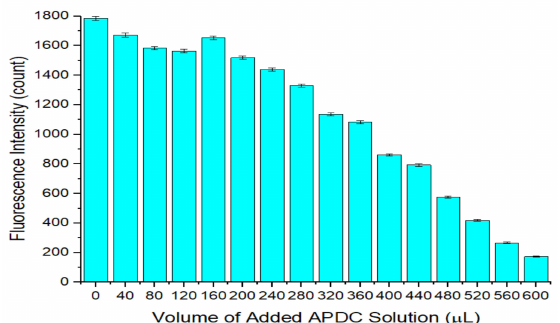
Figure 4. Relationship between the fluorescence intensity of the QD solution with added cadmium standard and the volume of the added APDC solution. Concentration of Tris-HCl bu ff er solution: 10 mmol / L. pH of Tris-HCl bu ff er solution: 8.5. Concentration of added QD solution: 5 µ mol / L. Concentration of added APDC solution: 100 µ mol / L. Concentration of cadmium standard solution: 1 g / L. Addition order: Tris-HCl bu ff er solution (2 mL) → QD solution (0.4 mL) → APDC solution (0–0.6 mL) → cadmium standard solution (0.001 mL) → Tris-HCl bu ff er solution (1.6–1 mL). Excitation wavelength: 460 nm. Observation time: 3 min. All data in this figure is mean of five